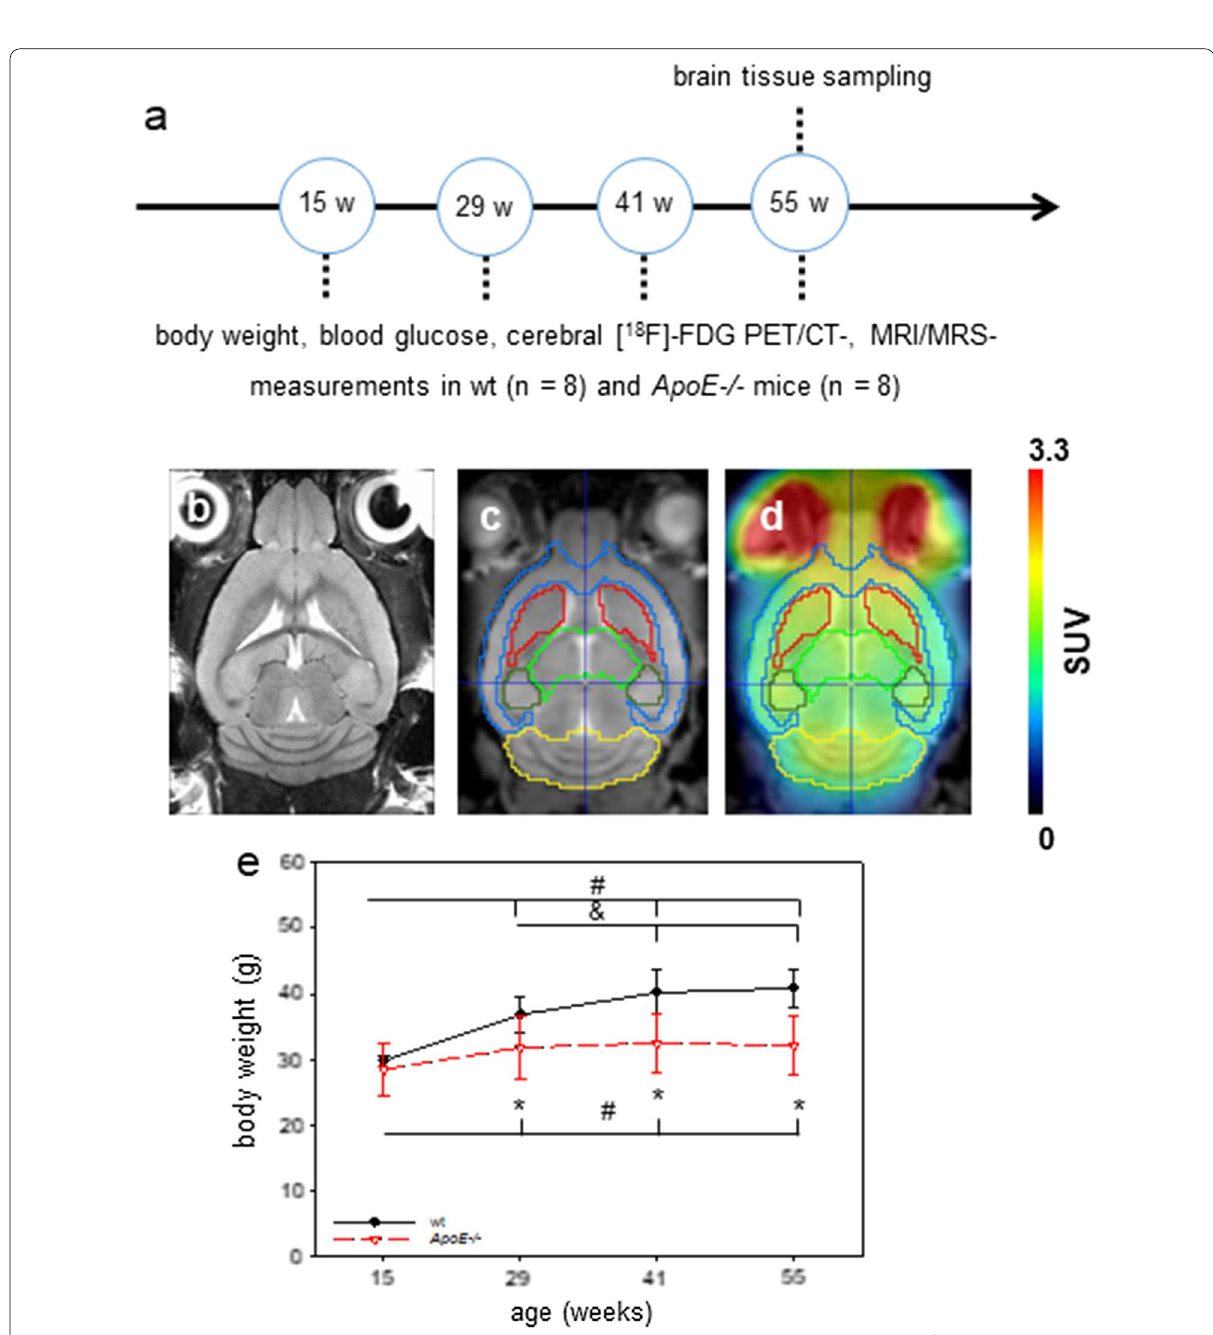
Fig. 1 a Schematic illustration of the experimental design. Body weight, blood glucose levels as well as cerebral [ 18 F]FDG-PET/CT and MRI/MRS measurement were evaluated at the age of 15, 29, 41, and 55 weeks (w) in wild type (wt, n 8) and Apolipoprotein E-deficient ( ApoE / , n 8) = − − = mice. b , c Transversal T2 weighted TurboRARE (in-plane resolution: 65 65 µm, slice thickness 500 µm) and transversal T1 weighted isotropic 3D × Flash (resolution: 120 120 120 µm) with M. Mirrione based mouse VOI template overlay (cortex—blue, striatum—red, thalamus—light green, × × hippocampus—dark green, cerebellum—yellow, brain stem—brown) of a wild type mouse. d Transversal [ 18 F]FDG-PET/CT and MRI with M. Mirrione VOI template fusion. e Body weights were measured directly before [ 18 F]FDG-PET/CT and MRI/MRS measurements. Values are given as mean SD; ANOVA for repeated measurements followed by Holm-Sidak comparison test: * p < 0.05 versus wt, # p < 0.05 versus 15 weeks, and p < 0.05 ± versus 29